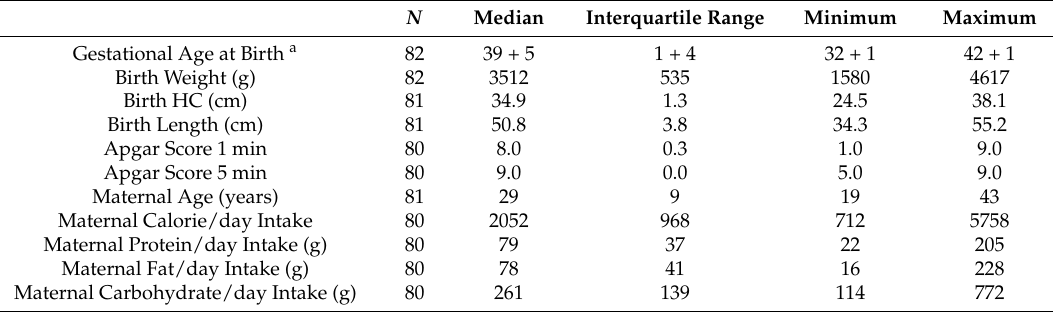
Table 1. Continuous responses of maternal and infant outcomes.